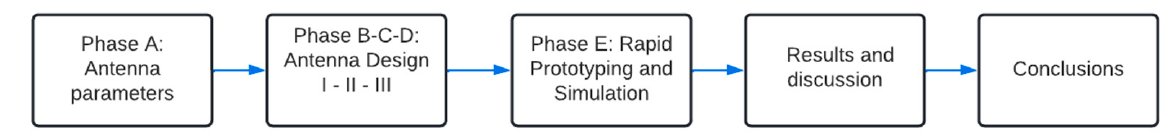
Figure 1. Proposed methodology.